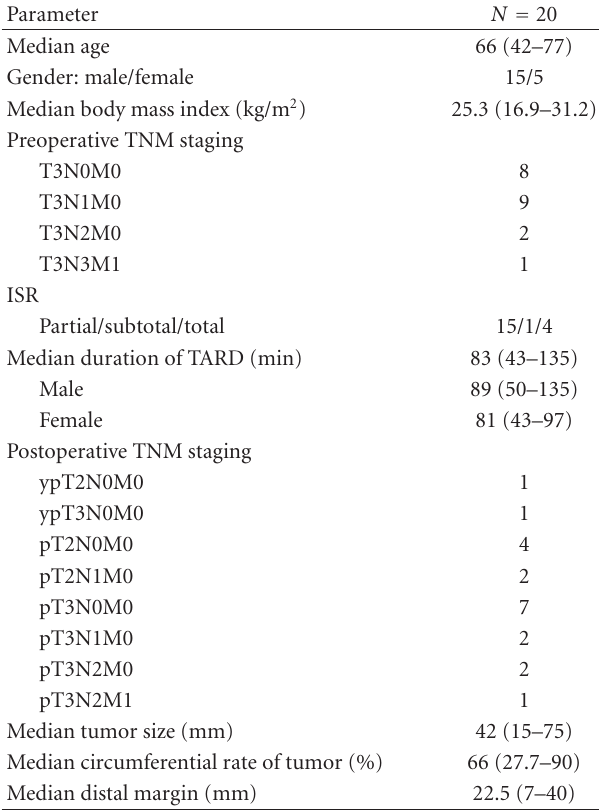
Table 1: Characteristics of